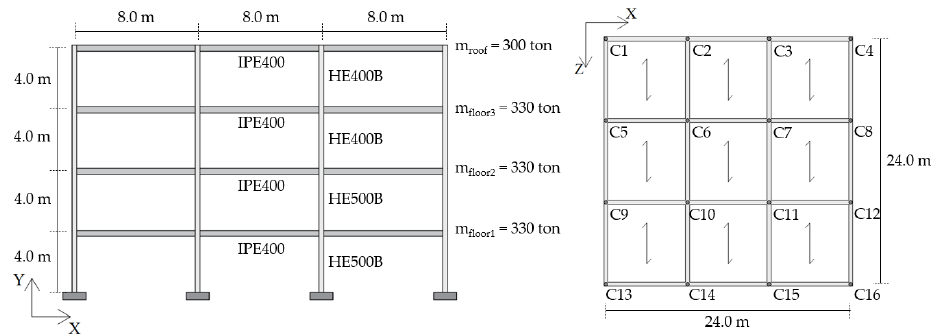
Figure 10. Elevation view and plan with the main dimensions of the steel case-study structure [59,60].